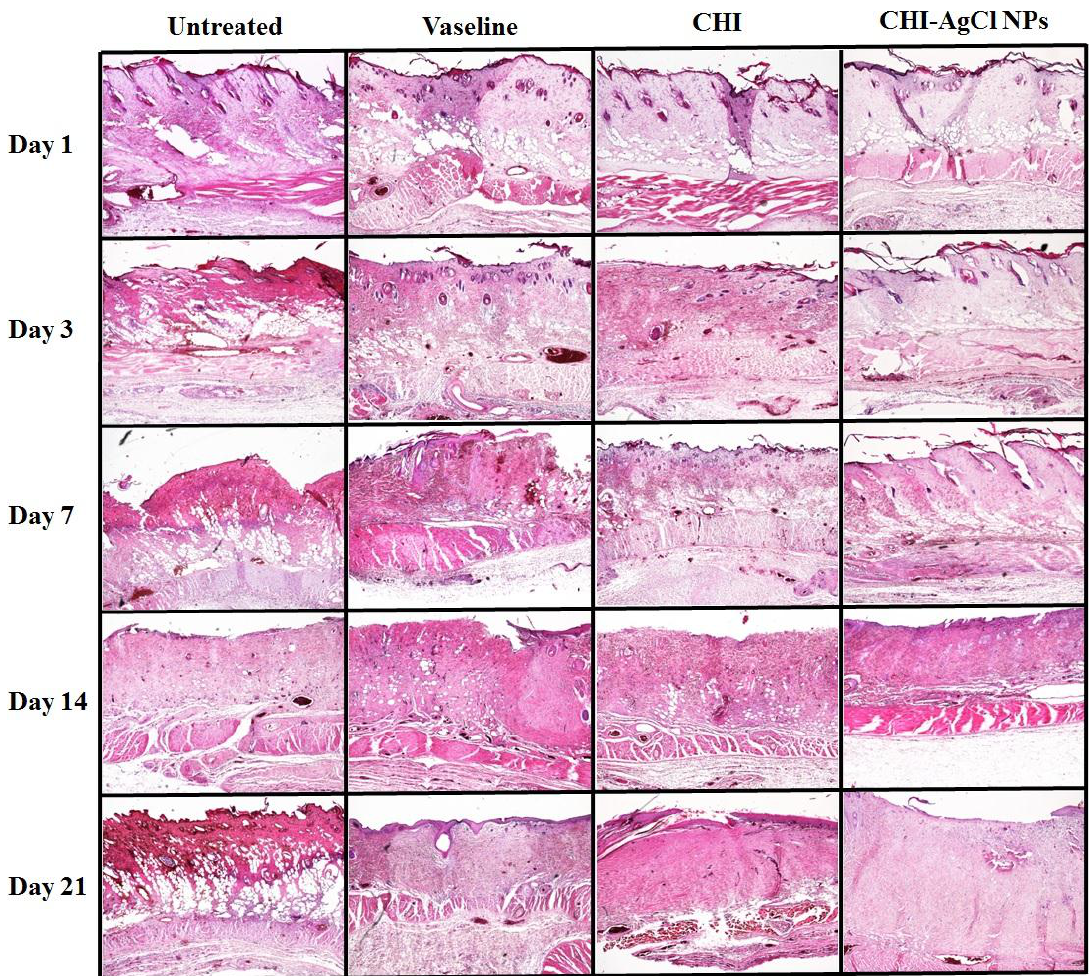
Figure 3. Evaluation of histopathology in the healing effect of ointments on burn induced skin damage using the H&E staining. The photographs were taken at an original magnification of ×40.